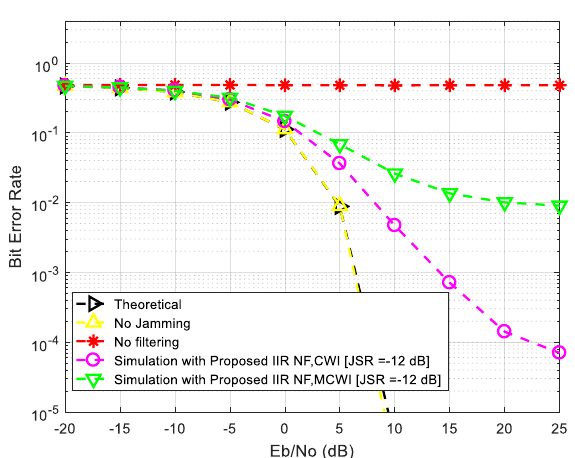
𝑬 𝒃 𝑵 𝒐 in the presence of MCWI.